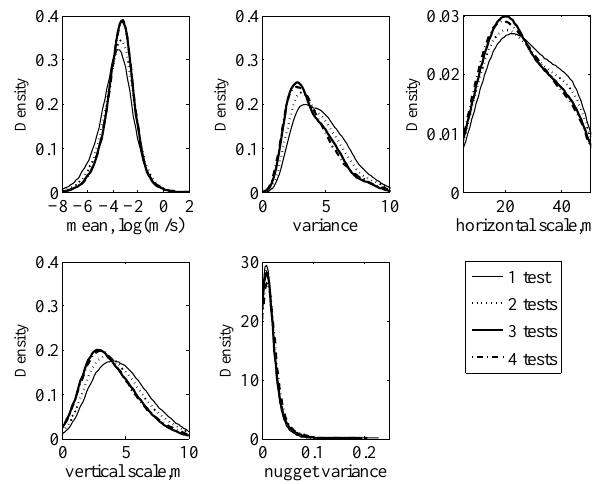
Fig. 9. Marginal posterior distributions of 3-D geostatistical struc- tural parameters of ln K values at the Hanford IFRC site, based on the different number of injection